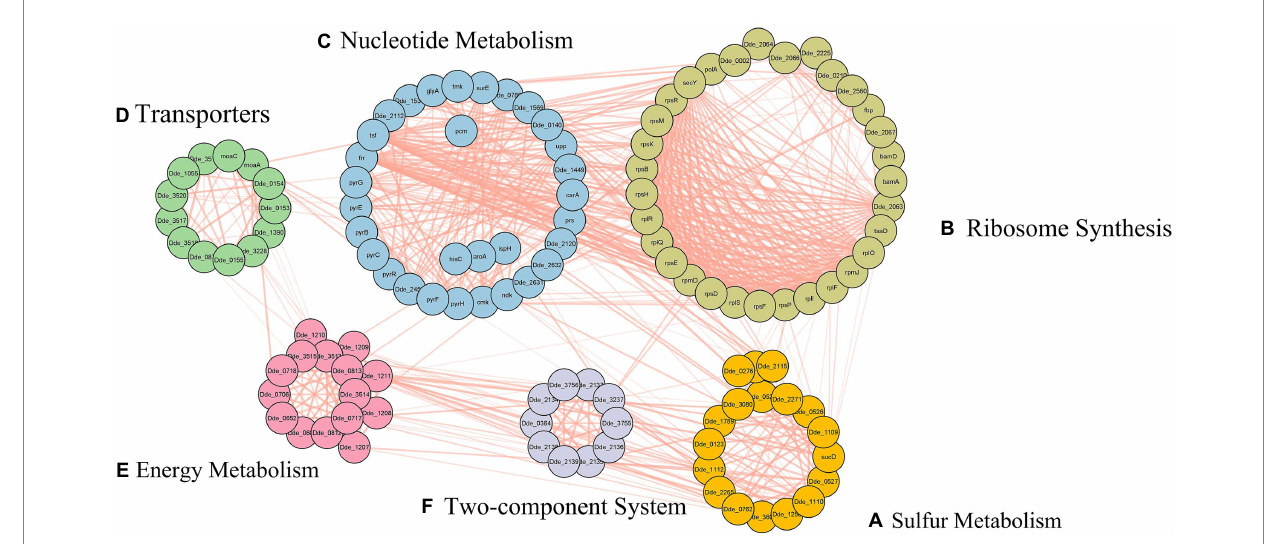
FIGURE 4 Protein–protein interactions of the enriched gene set, subcategorized under, (A) sulfur metabolism, (B) ribosome synthesis, (C) nucleotide metabolism, (D) transporters, (E) energy metabolism, and (F) two-component system.